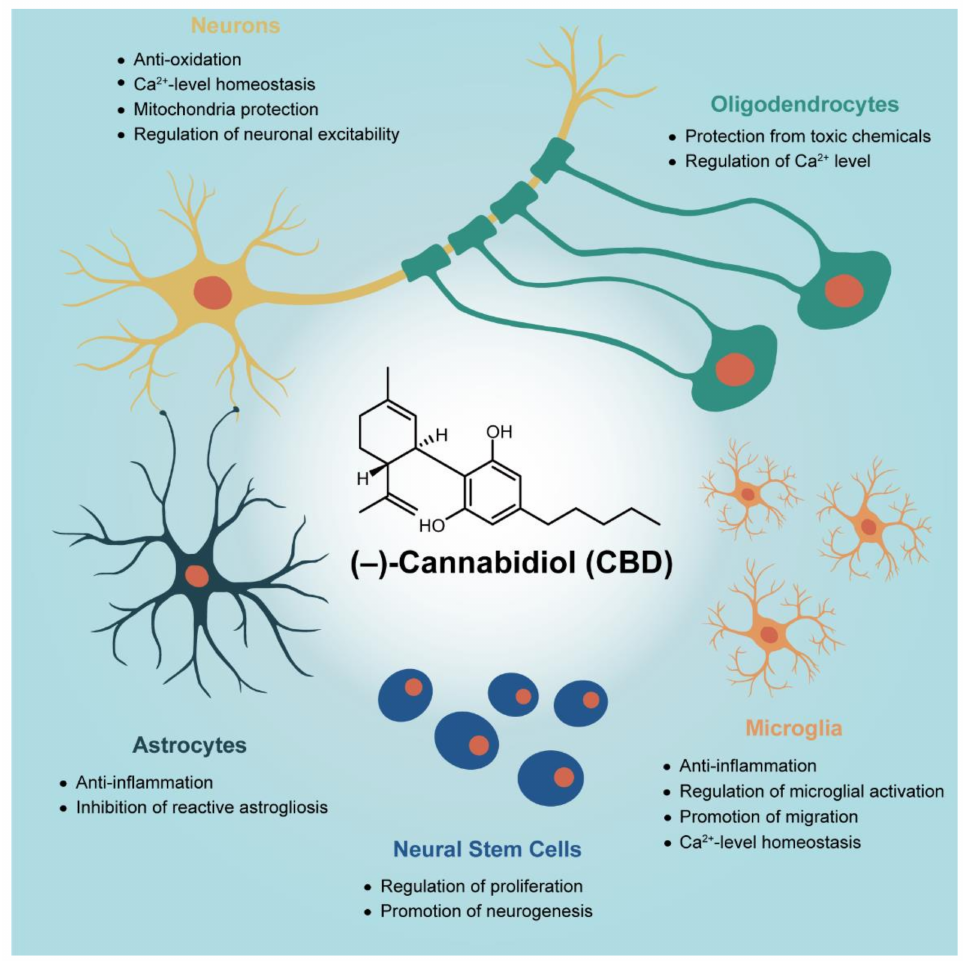
Figure 1. Reported CBD actions on neural